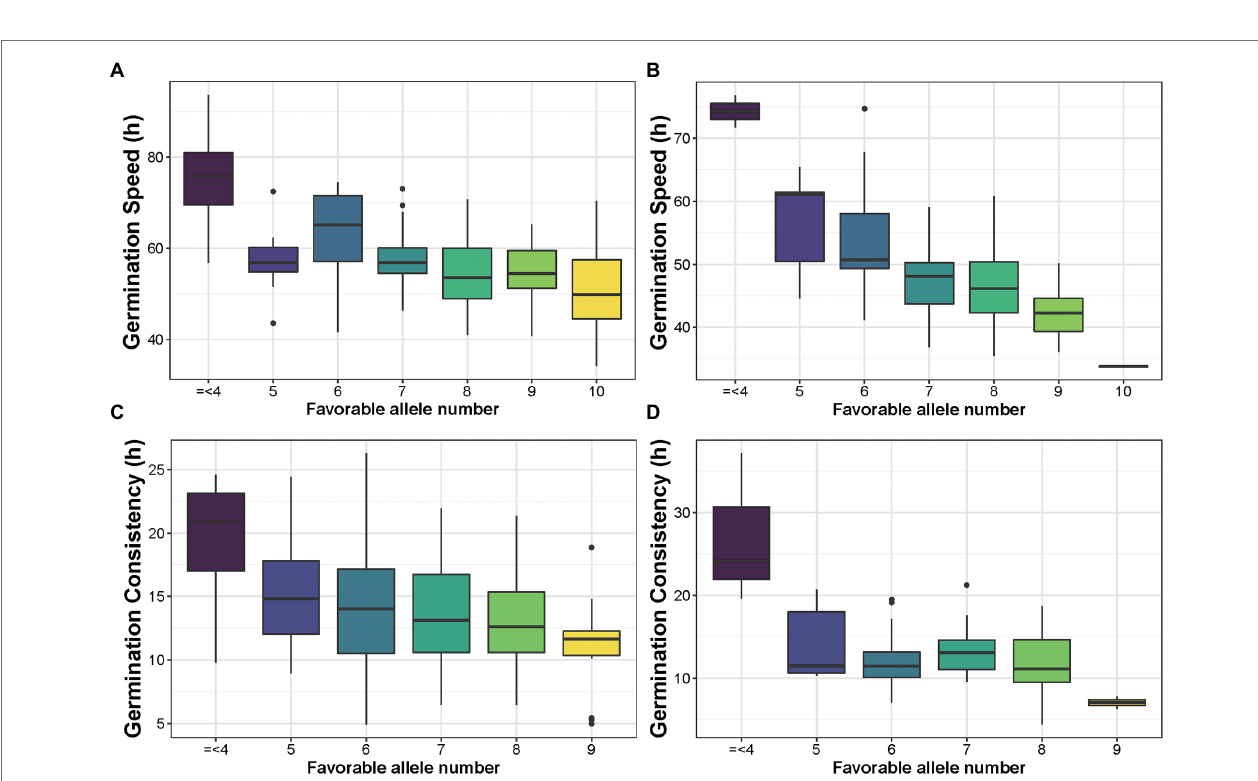
FIGURE 7 | Boxplot of favorable alleles pyramiding for GS and GC in two germination traits. (A) Analysis of favorable alleles pyramiding for GS in the temperate subpopulation. (B) Analysis of favorable alleles pyramiding for GS in the tropical subpopulations. (C) Analysis of favorable alleles pyramiding for GC in the temperate subpopulation. (D) Analysis of favorable alleles pyramiding for GC in the tropical